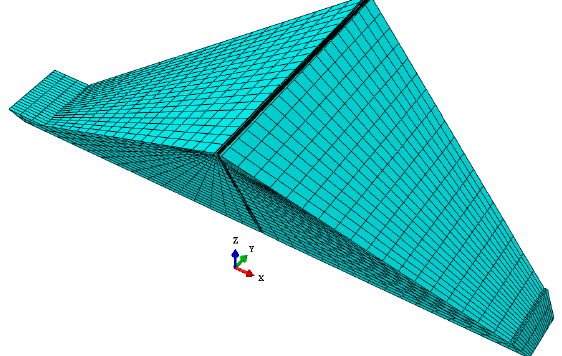
Figure 5. Meshes of FEM standard model for ACCRDs . Table 1. Characteristic parameters of dam materials (E-B model).